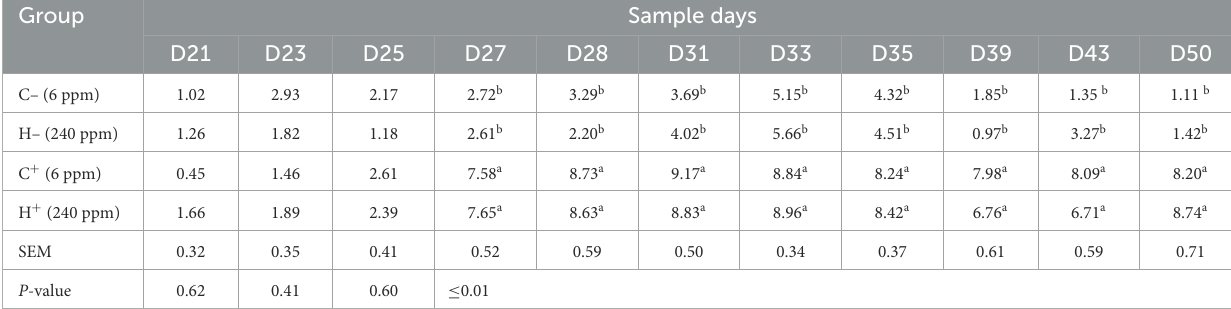
TABLE 4 Mean cefotaxime-resistant isolates numbers in the individual fecal samples (log10 CFU/g). Group